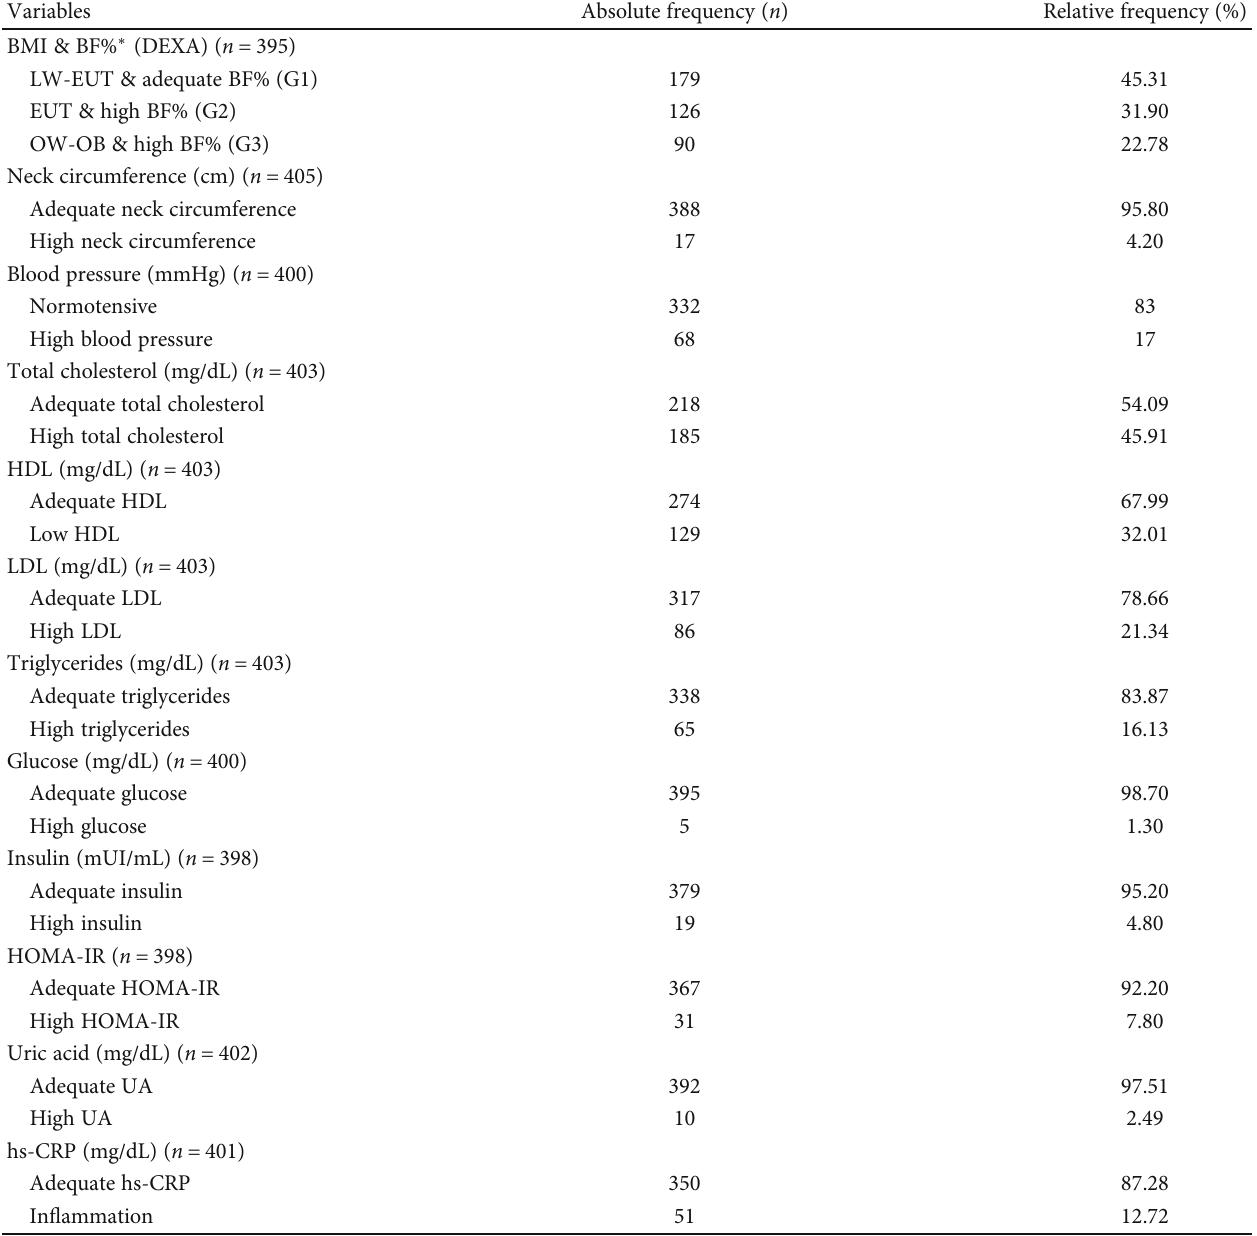
Table 1: Absolute and relative frequencies of female adolescents ’ lifestyle cardiometabolic diseases risk